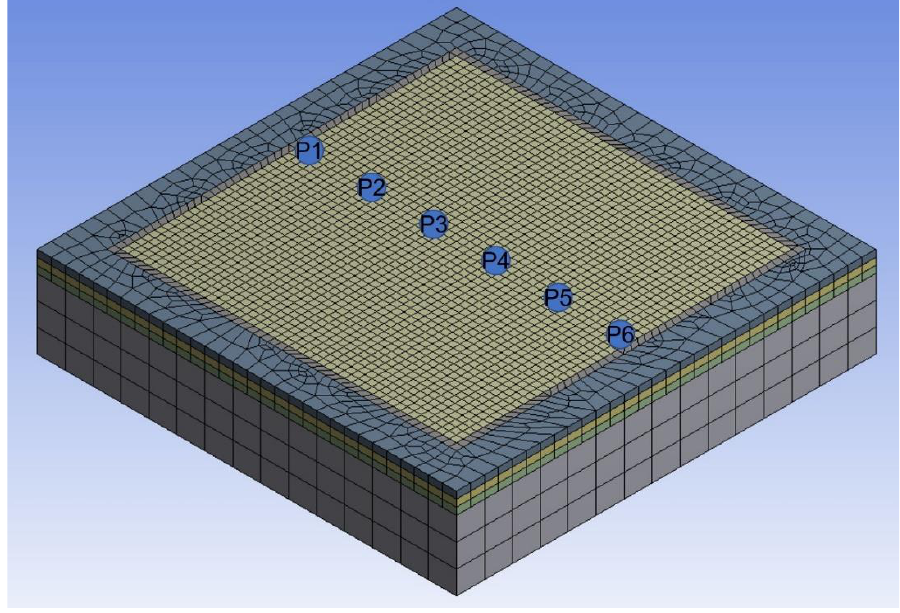
Figure 2. FEM model of basic numerical study.